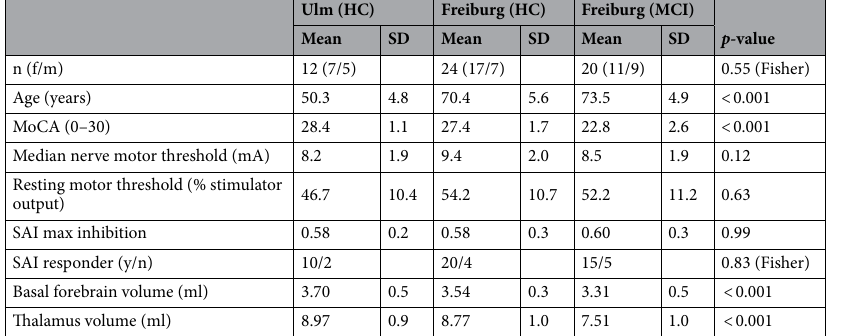
Table 1. Socio-demographic data of the sample and group comparison for cholinergic structure and function. We used multivariate ANOVA for group comparison if not stated otherwise. SD Standard deviation, HC Healthy controls, MCI Mild Cognitive Impairment, f/m female/male, MoCA Montreal Cognitive Assessment, SAI Short-latency sensory afferent inhibition, y/n number yes/number